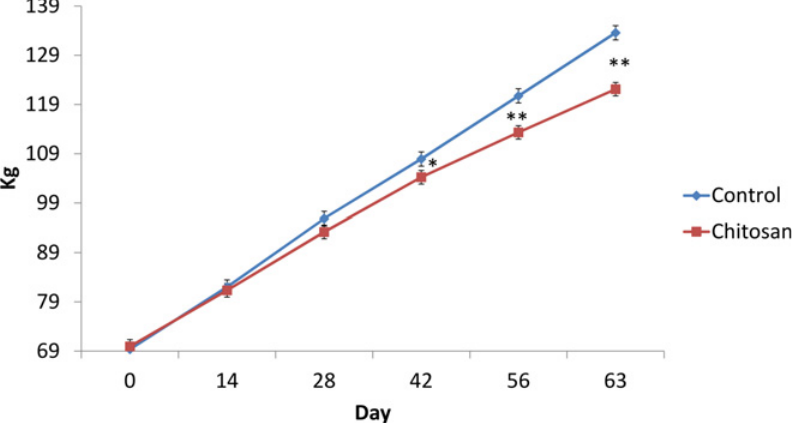
Fig 1. Effect of dietary supplementation on body weight over time at days 0, 14, 28, 42, 56 and 63. * P < 0.05 ** P < 0.001. Treatment effect P < 0.001. Time effect P < 0.001. Time x treatment effect P < 0.01. Values are means, with their standard errors represented by vertical bars.